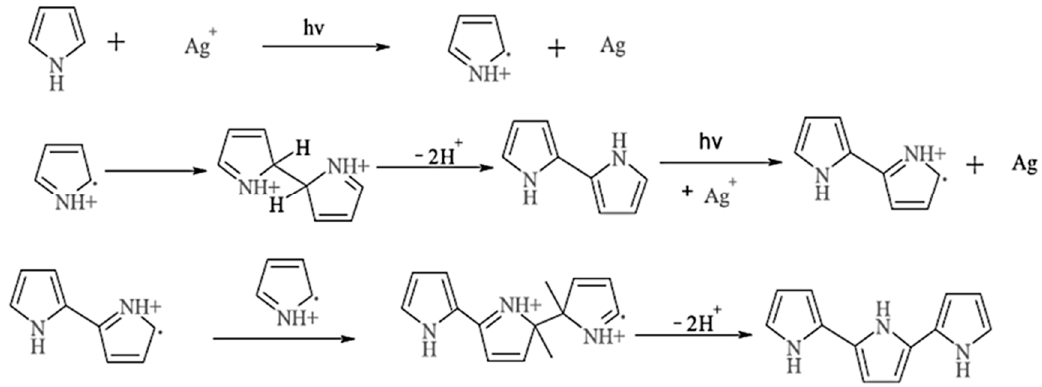
Figure 2. Photoplymerization mechanism of pyrrole.